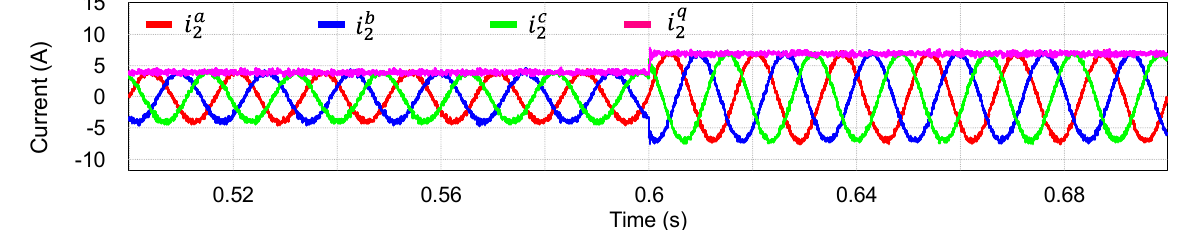
Figure 14. Simulation results of three-phase grid currents for the proposed control scheme under distorted grid voltages when the current reference has a step change from 4 A to 7 A.